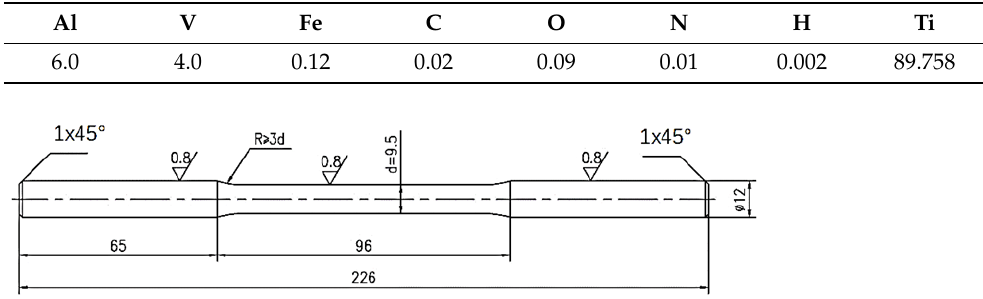
Table 1. Main chemical components of TC4 titanium alloy.